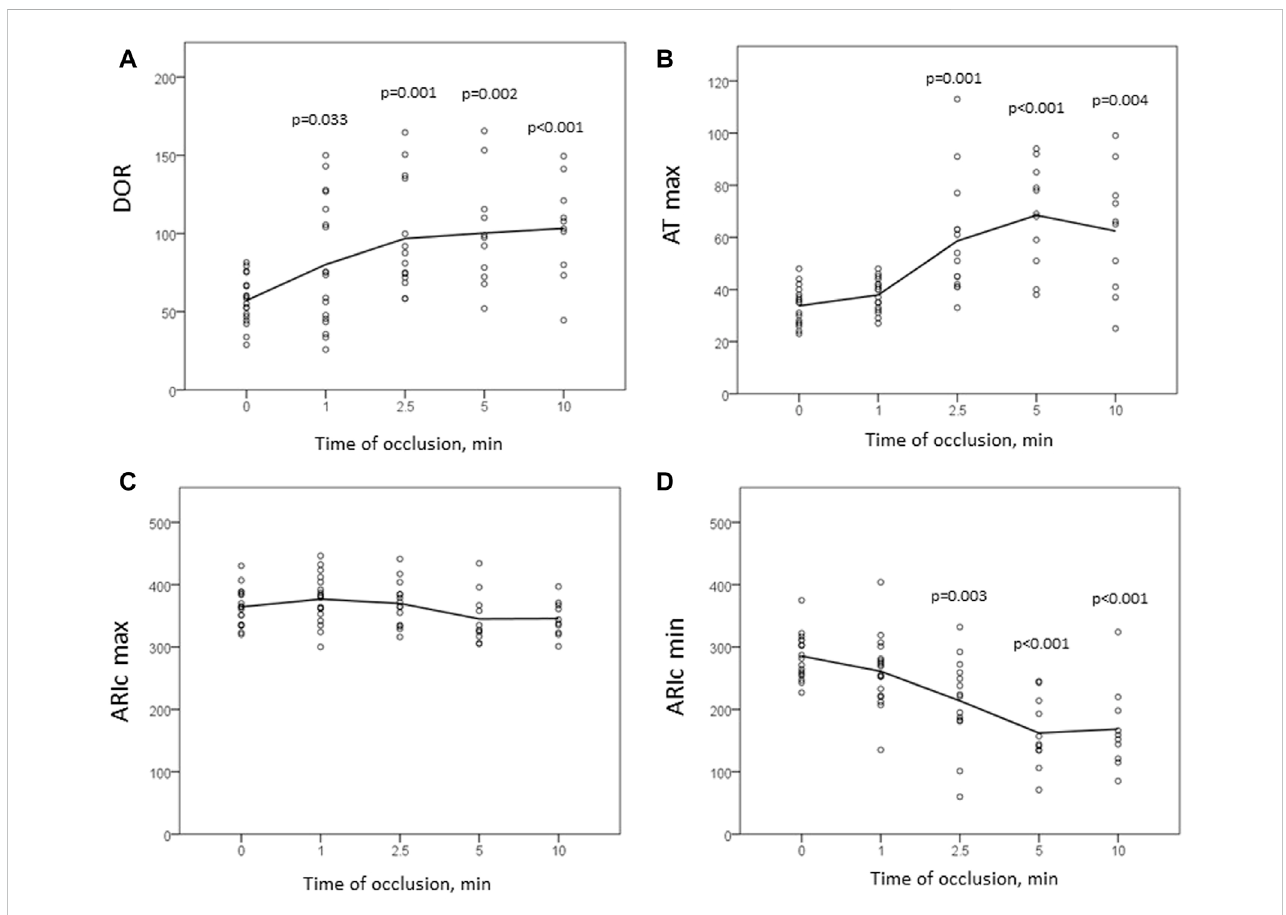
FIGURE 3 Dynamics of mapping parameters re fl ecting major prerequisites of reentrant arrhythmias: DOR (A) , maximal AT (B) , maximal and minimal ARIc ( (C,D) , respectively). Indicated are p -values vs. baseline.